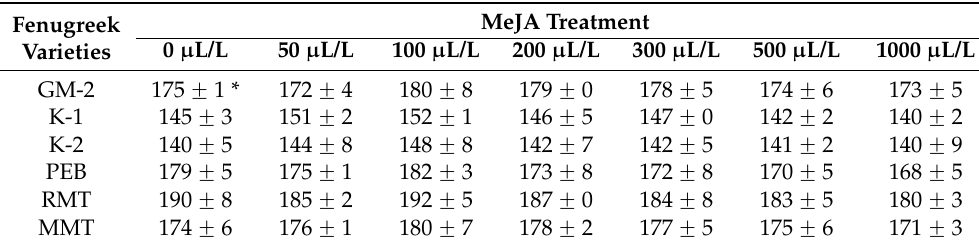
Table 4. Effect of methyl jasmonate (MeJA) treatments on the fresh weight (mg) of seedlings of different fenugreek ( Trigonella foeum-graecum L.) varieties.